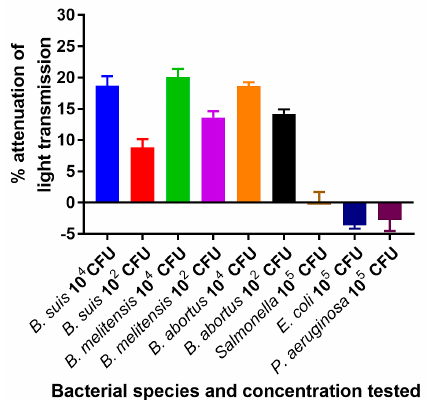
Figure 5. Detection of Brucella DNA amplified by PCR from B. suis , B. abortus, and B. melitensis by